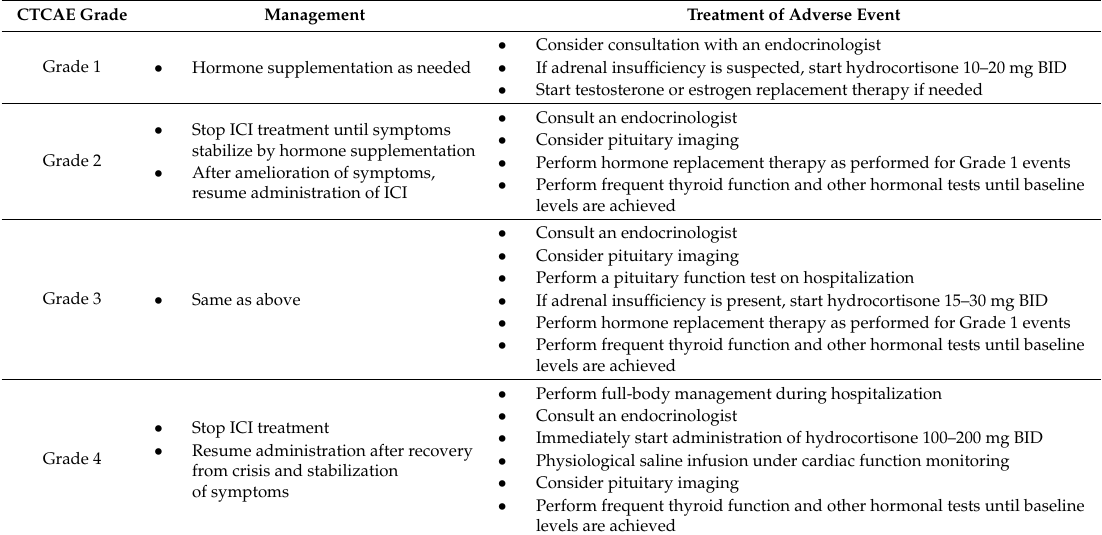
Table 2. Management of hypopituitarism induced by immune checkpoint inhibitors.